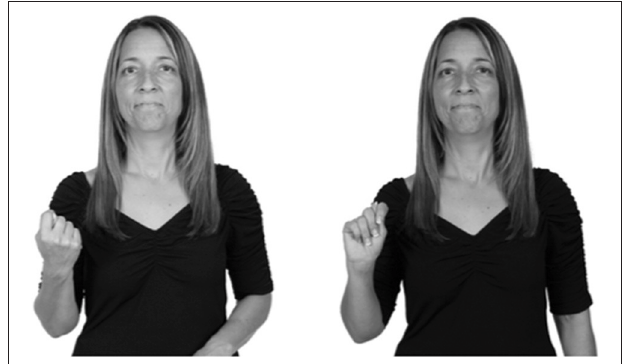
FIGURE 3 | The ASL signs TUESDAY (left) and BATHROOM (right) . Photographs are reproduced with written permission of the